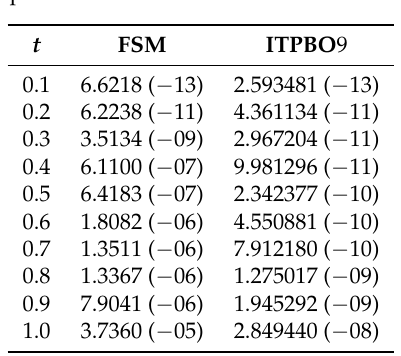
Figure 2. Efficiency curves of log maximum absolute error versus step size, h. ( a ) Problem 1, ( b ) Problem 2. Table 1. Comparison of the absolute errors on Problem 1, h = 0.1.